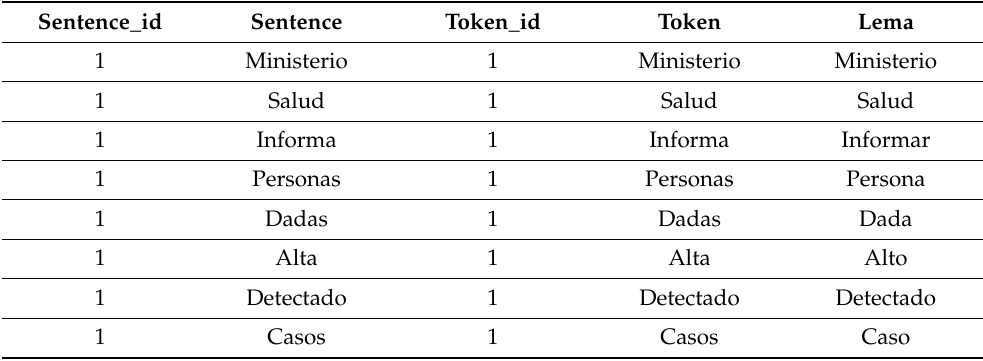
Table 1. Lemmatization of